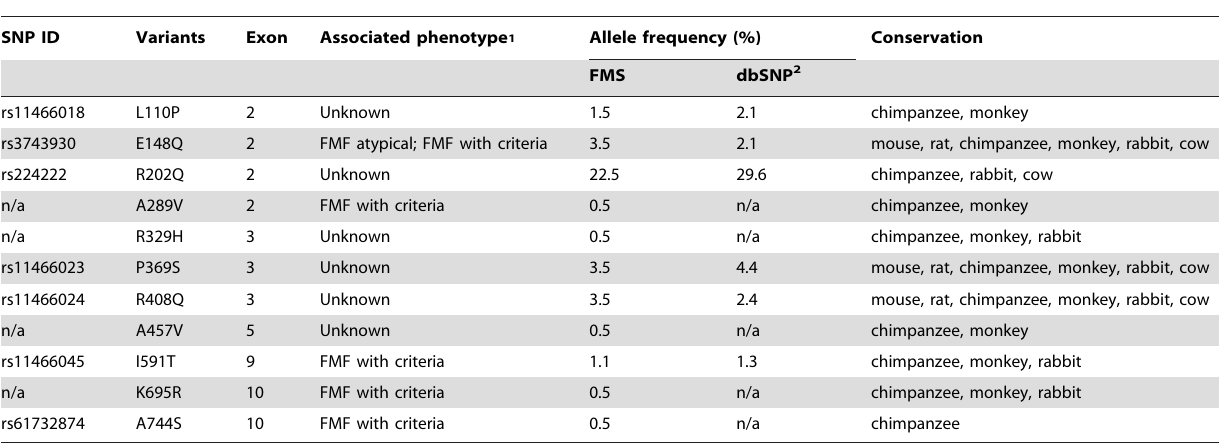
Table 1. MEFV mutations identified in the